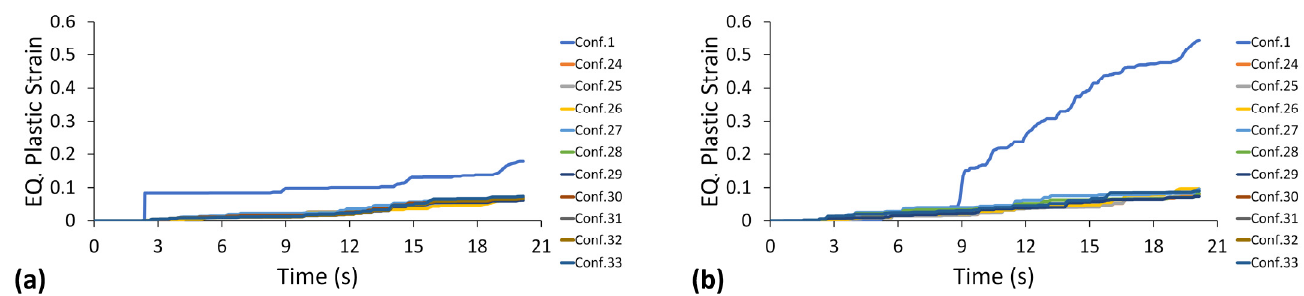
Figure 9. Equivalent plastic strain in different configurations under the Nahanni earthquake: in the ( a ) column and ( b ) beam.